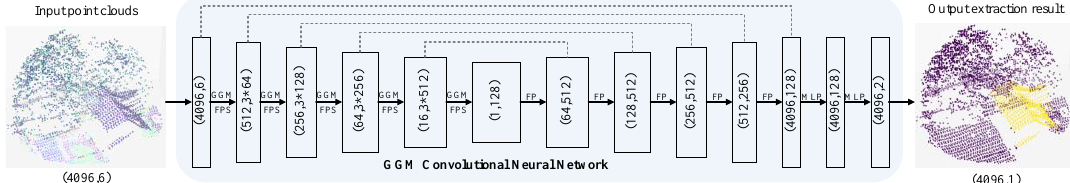
Figure 7. GGM convolutional neural networks architecture. ( N , D ) represents the number of points and feature dimension respectively. GGM: graph geometric moment convolution, FPS: farthest point sampling, FP : feature propagation, MLP: multi-layer